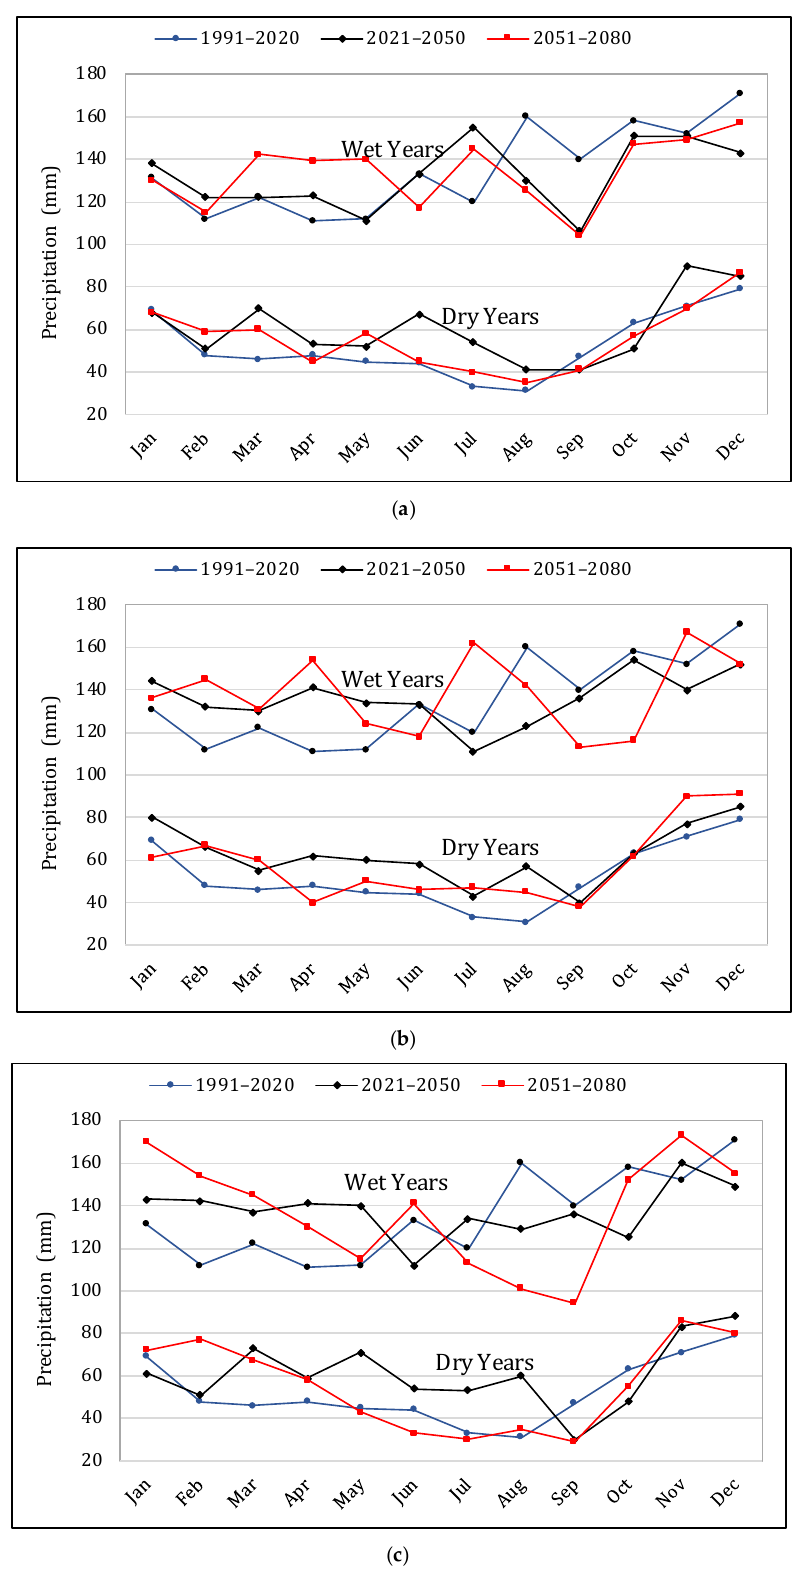
Figure 7. Expected monthly precipitations during wet (PoE = 20%) and dry years (PoE = 80%) under the RCP2.6 ( a ), RCP4.5 ( b ), and RCP8.5 ( c ) scenarios in the central zone (Charlottetown). The observed and expected streamflows (mm) in the central zone are provided in Table 10. The simulated mean monthly streamflows (m 3 /s) were extracted from the re- spective subwatersheds of the monitoring points, i.e., 53 and 25 (Figure 2) for the West and Winter River watersheds, respectively. Weighted average streamflows of the central zone (Figure 2) were converted into mm to better grasp the results, as shown in Table 10. Table 10. Average streamflows (mm) observed in the central zone (at Riverdale and Suffolk of the West and Winter River watersheds, respectively) during the 2000s and modeled future projections during the 2030s and 2060s. Streamflows (mm) (429) Note: Means that do not share a letter are significantly different at α = 0.05 (95% confidence) as per Tukey’s method. Note: bracketed values are pumping adjusted as detailed in Section 2.3 . Bolded values highlight significantly different ones in the text, the annual are bolded because they repre- sent sum total of all the months.